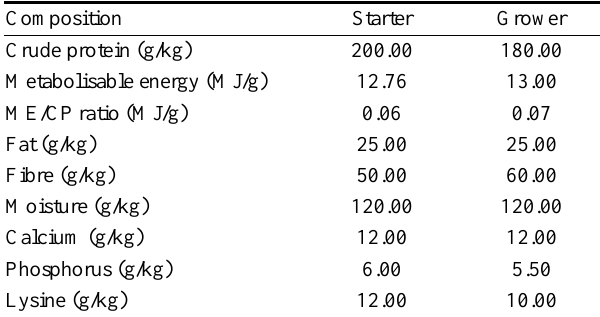
Table 2. Chemical composition (label values) of commercial broiler starter and grower feeds used in the study 1 Composition Starter